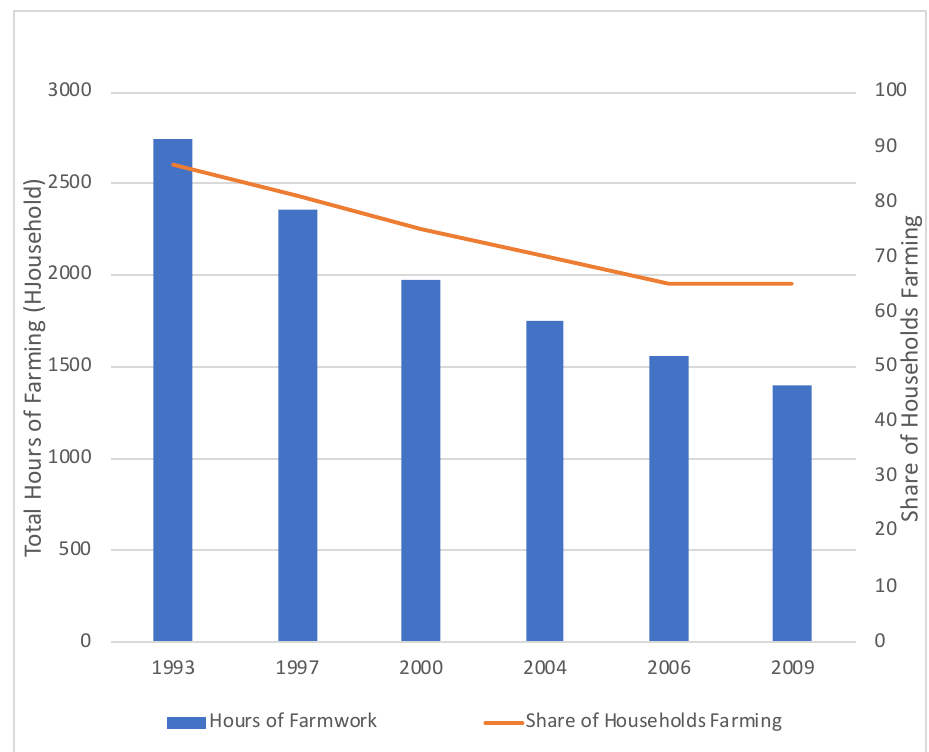
Figure 2. Hours of Farmwork and Share of Households Farming, by Survey Round, Rural Areas of Chi- na, China Health and Nutrition